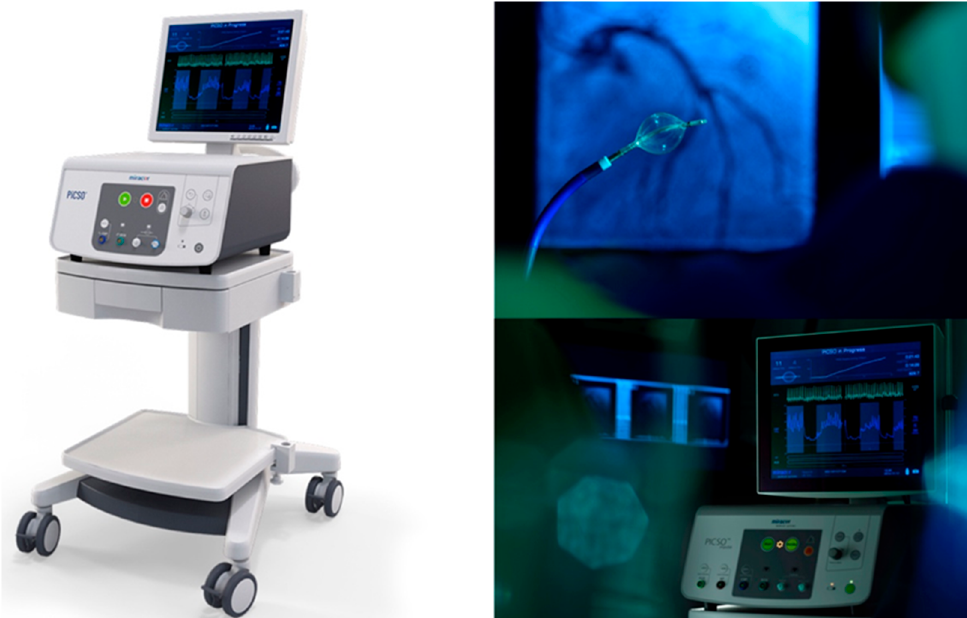
Figure 2. Pressure-controlled intermittent coronary sinus occlusion (PICSO) impulse system. A balloon-tipped catheter is introduced in the coronary sinus. The catheter, which is connected to a console, is able to monitor coronary sinus pressures and automatically inflates and deflates in a periodic way. Images courtesy of Miracor Medical Systems GmbH, Vienna, Austria.